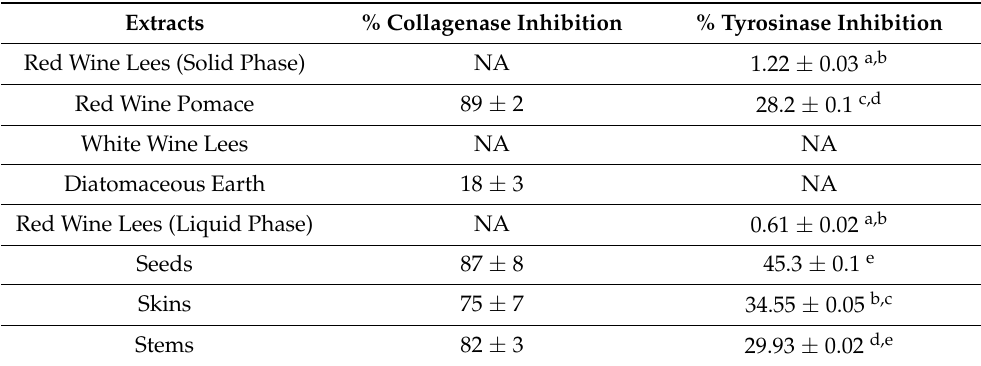
Table 6. Percentage of tyrosinase and collagenase inhibition towards extracts of winemaking residues. Extracts % Collagenase Inhibition % Tyrosinase Inhibition Red Wine Lees (Solid Phase) NA Red Wine Pomace White Wine Lees NA NA Diatomaceous Earth 18 ± 3